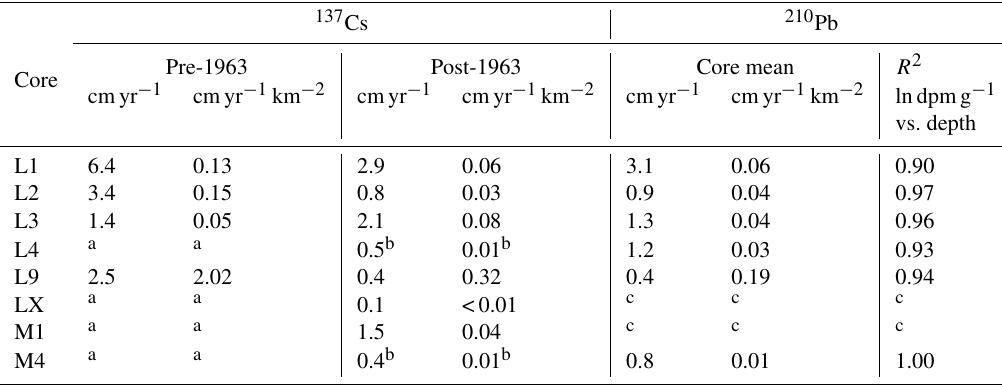
Table 2. Linear sedimentation rates derived from radioisotope activities.